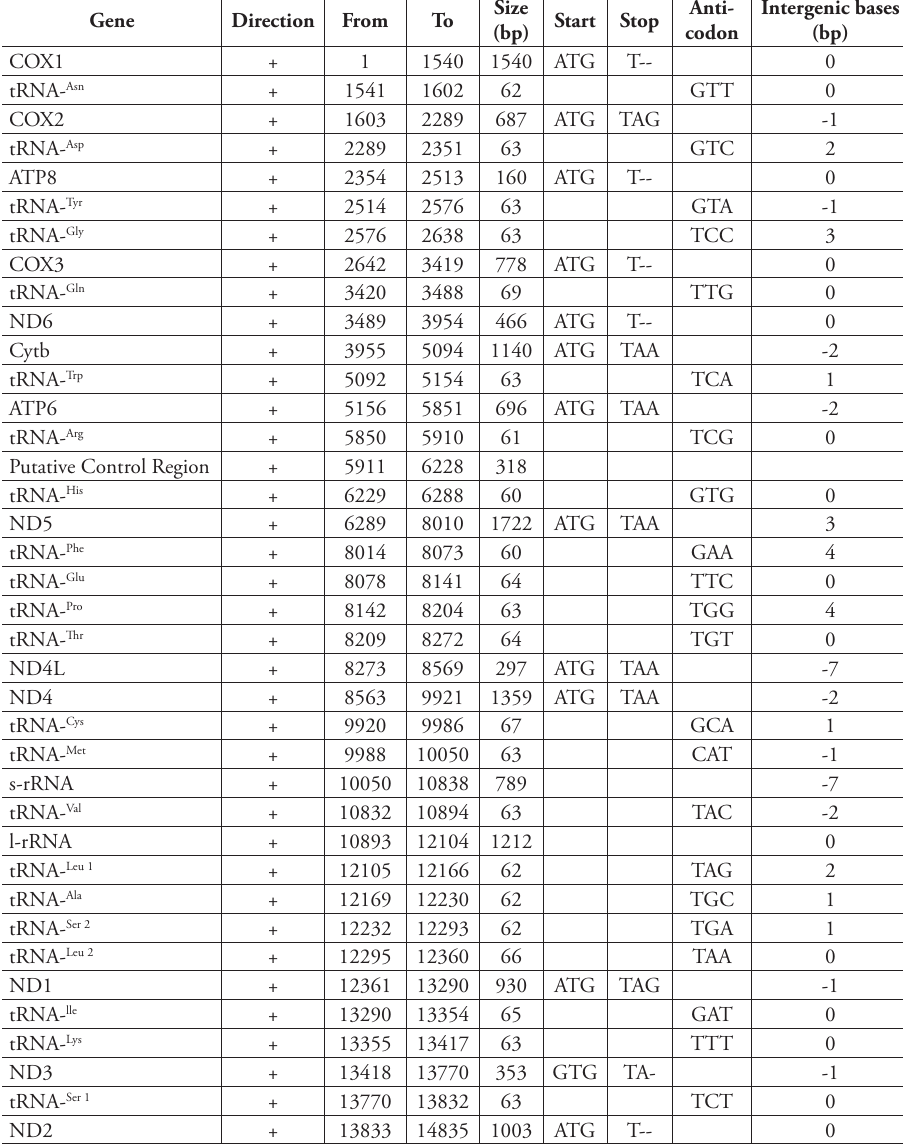
Table 3. Organisation and structure of the P. corethrurus mitochondrial genome. Gene Direction From To